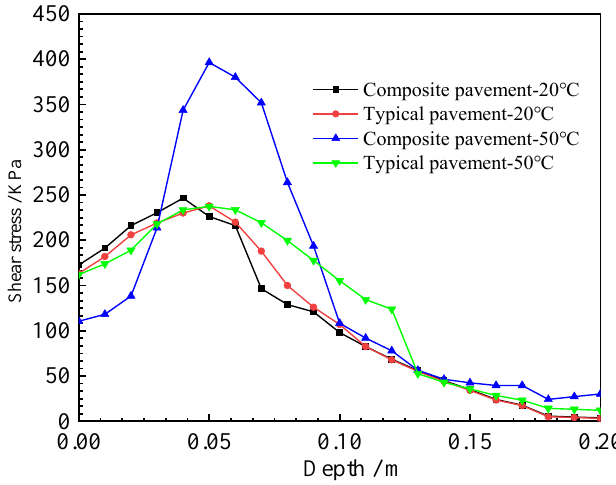
Figure 18. Shear stress in the depth. The maximum shear stress at the bottom of the upper layer decreases with increases in the load distance, as shown in Figure 17. The maximum shear stress at the bottom of the upper layer of the PU composite pavement and the typical asphalt pavement structure at 10 ◦ C and 50 ◦ C is similar to the lateral distribution of the road. The temperature has little effect on the upper-layer maximum shear stress of the typical asphalt pavement structure, except the wheel load position. The interlayer shear stress of the composite pavement load position under high-temperature conditions reaches 254